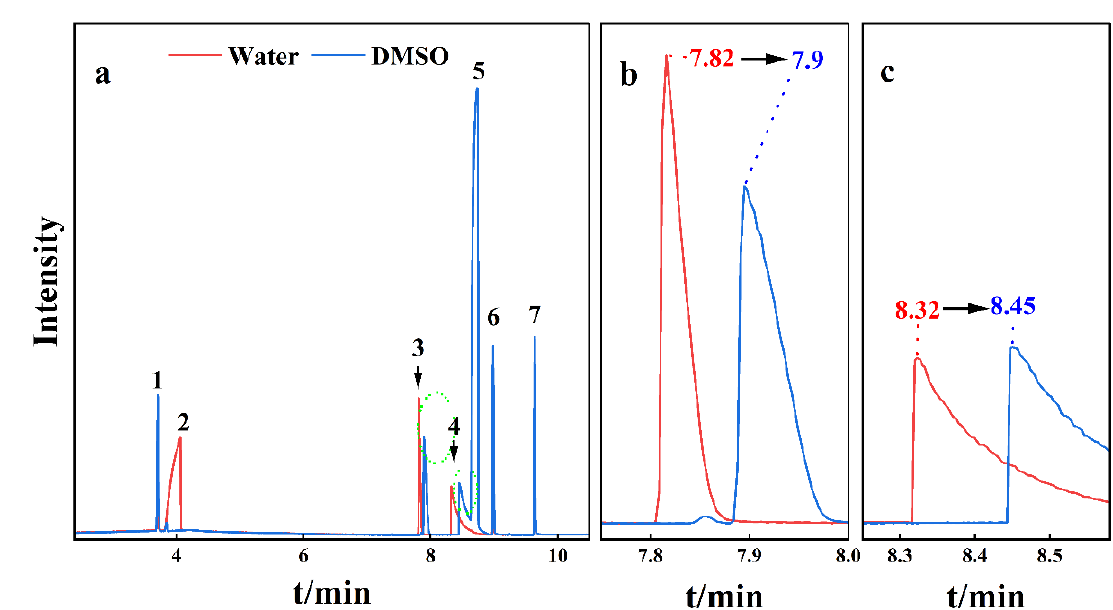
Figure 2. Comparison of retention times of six compounds in water and DMSO. ( a ) Retention times of six compounds in water and DMSO; ( b ) enlarged view of the peak of acetic acid (green circled area indicated by position 4 from Figure 2a; ( c ) Enlarged view of the peak of formic acid (green circled area indicated by position 5 from Figure 2a. Peak identifications: 1. toluene; 2. water; 3. acetic acid; 4. formic acid; 5. DMSO; 6. butyric acid; 7. valeric acid.